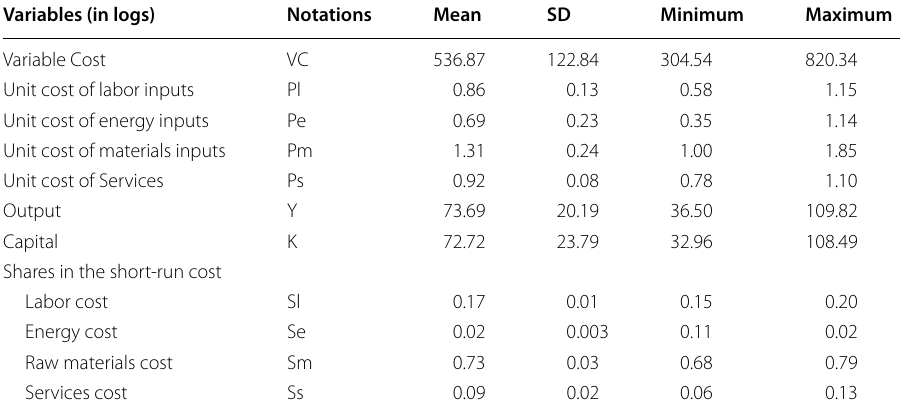
Table 1 Summary statistics for the variables used in estimation Variables (in logs)